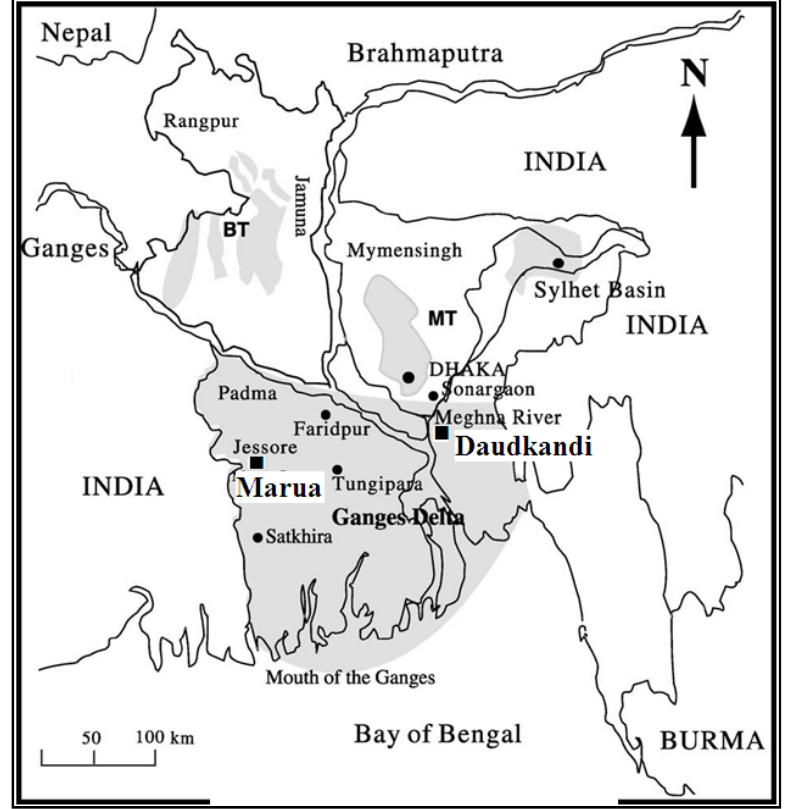
Figure 1. Map showing the study areas, Daudkandi and Marua in